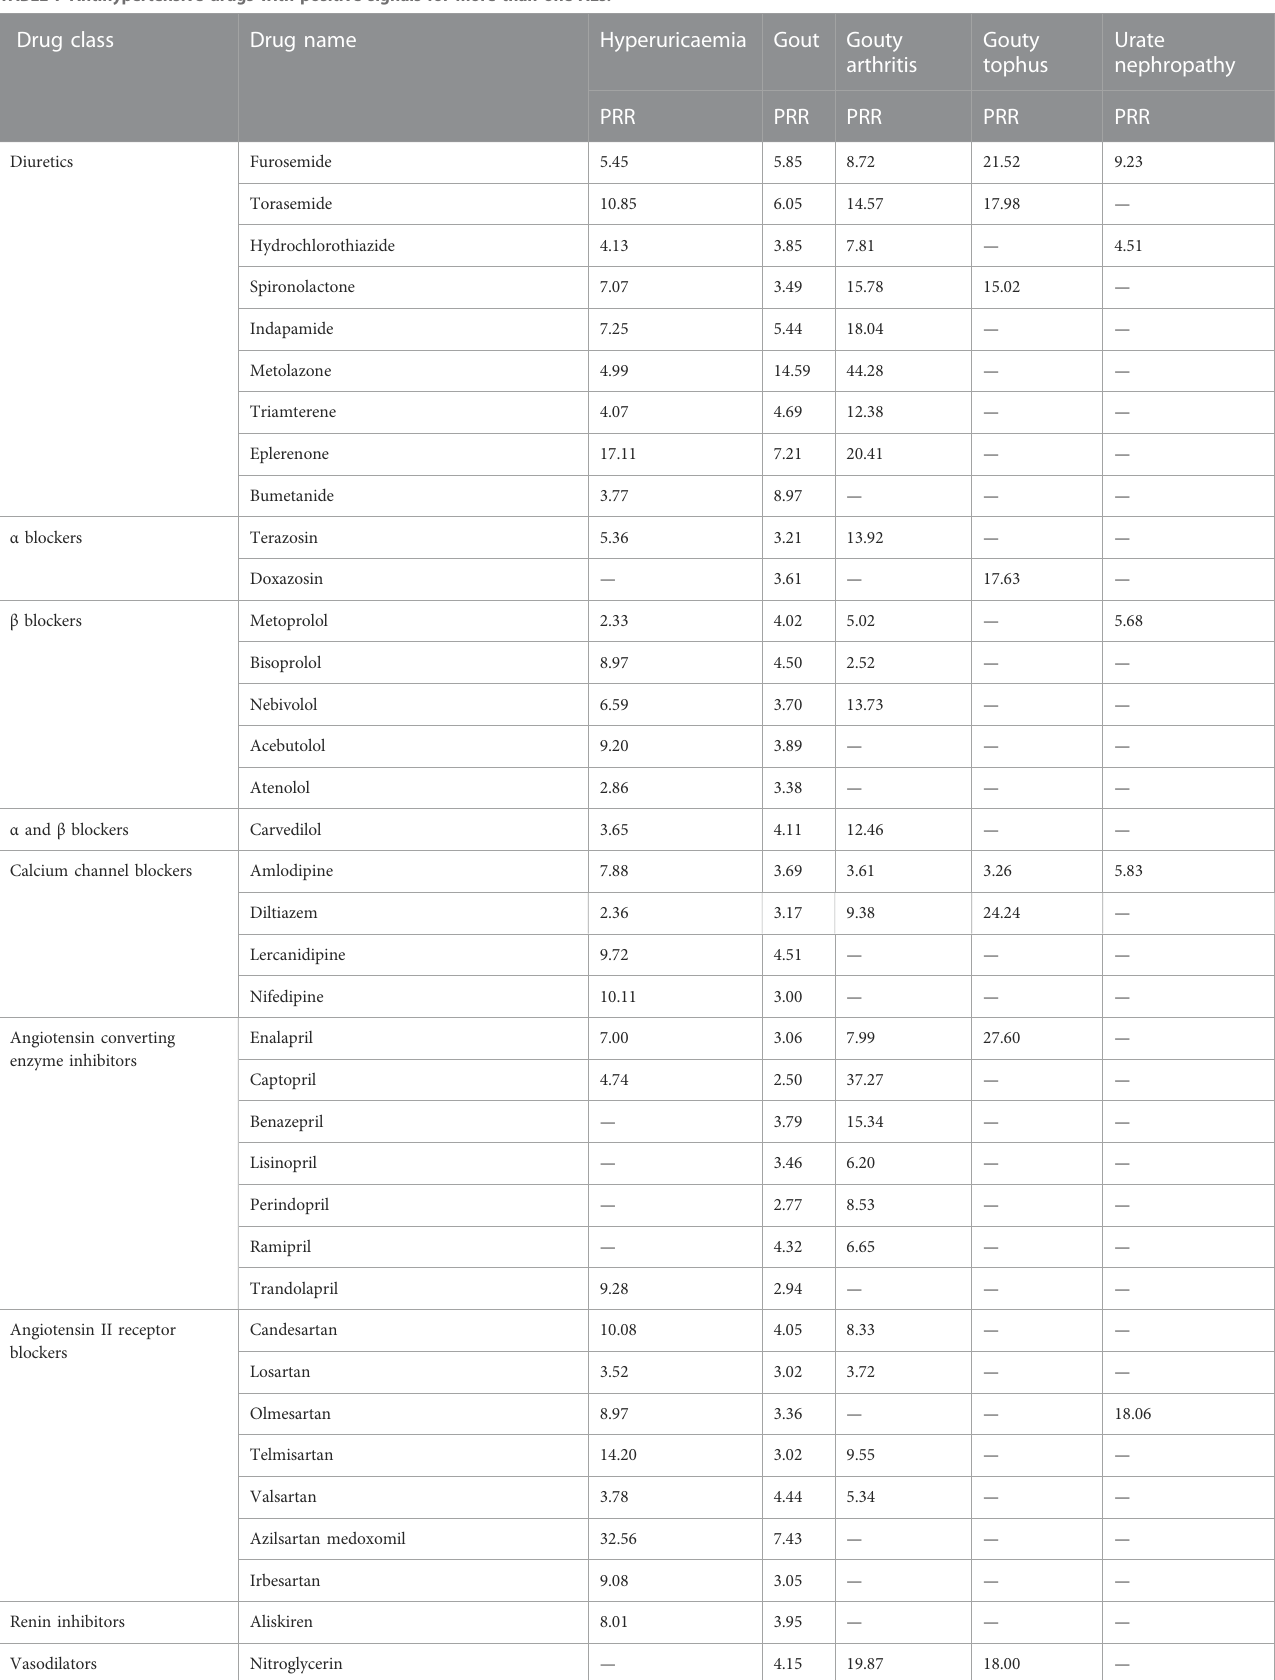
TABLE 7 Antihypertensive drugs with positive signals for more than one AEs. Drug class